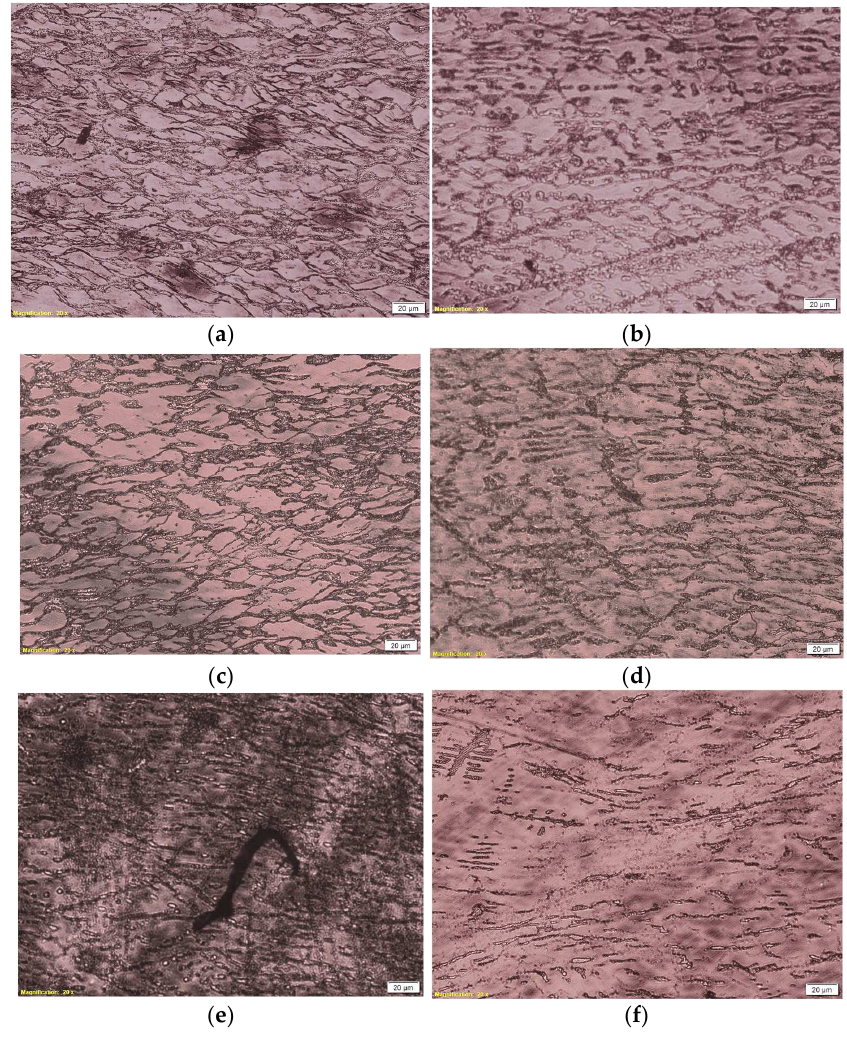
Figure 9. Optical micrographs of deformed Fe-21.3Mn-7.6Al-4.3Cr-1C under different deformation conditions: ( a ) 800 °C at 0.1 s −1 ; ( b ) 800 °C at 5 s −1 ; ( c ) 900 °C at 0.1 s −1 ; ( d ) 900° C at 5 s −1 ; ( e ) 1000 °C at 0.1 s −1 ; ( f ) 1000 °C at 5 s −1 .